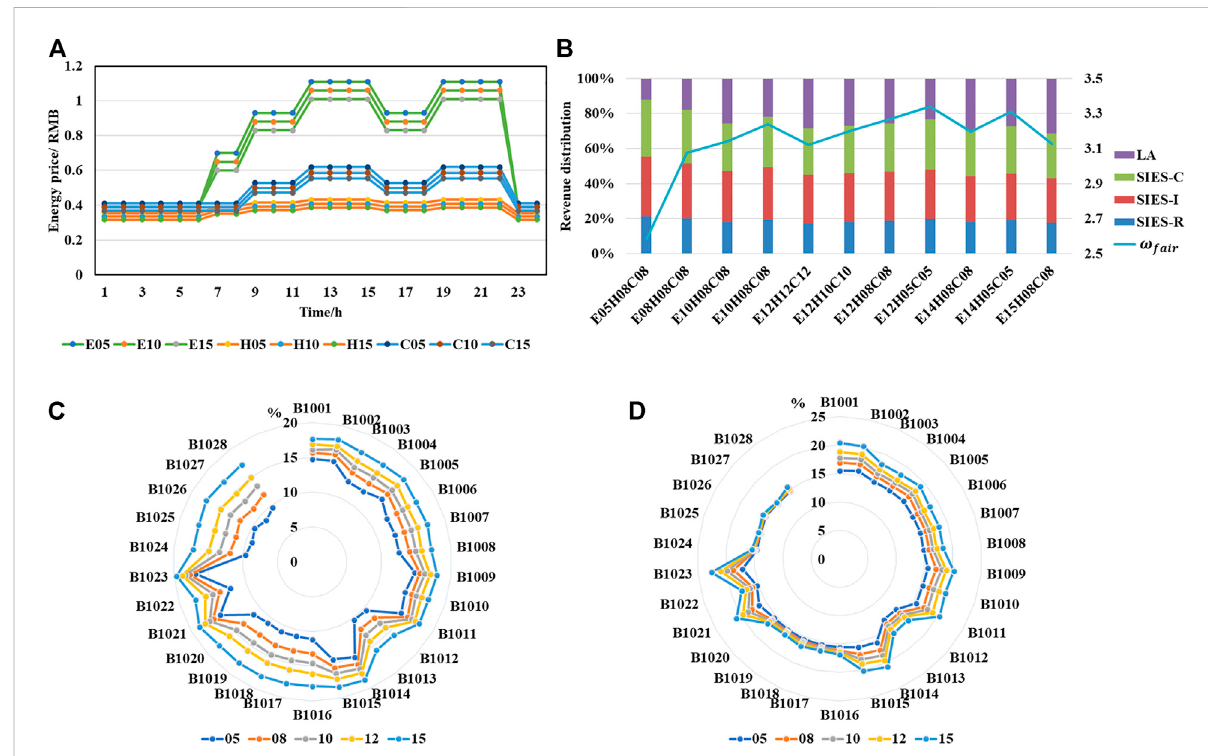
FIGURE 10 The results of the sensitivity analysis of energy prices. Figure (A) shows the variation of energy prices with time. Figure (B) shows the pro fi t distribution between LA and suppliers at various prices. Figure (C) shows the impact of electricity prices on cost reduction by the percentage of different users. Figure (D) shows the impact of heating and cooling prices on cost reduction by the percentage of different